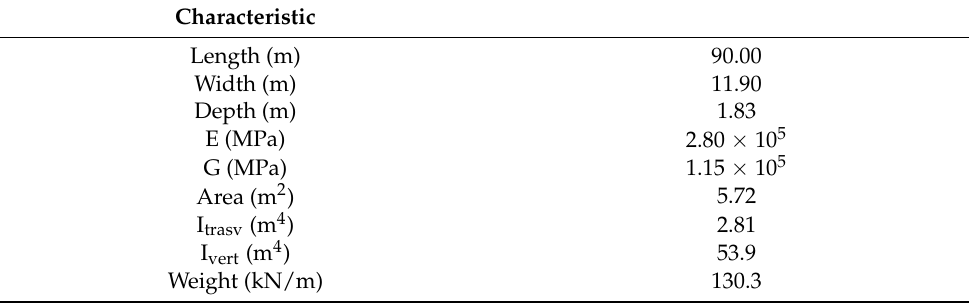
Figure 3. ( a ) Benchmark bridges (vertical view). ( b ) Benchmark bridges (plan view). Table 2. Deck characteristics.